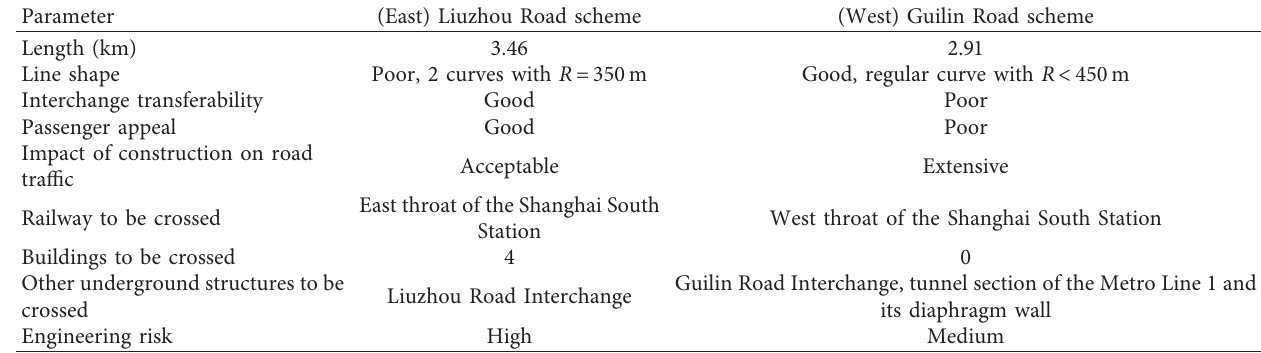
Table 2: Comparison of the proposed route schemes.